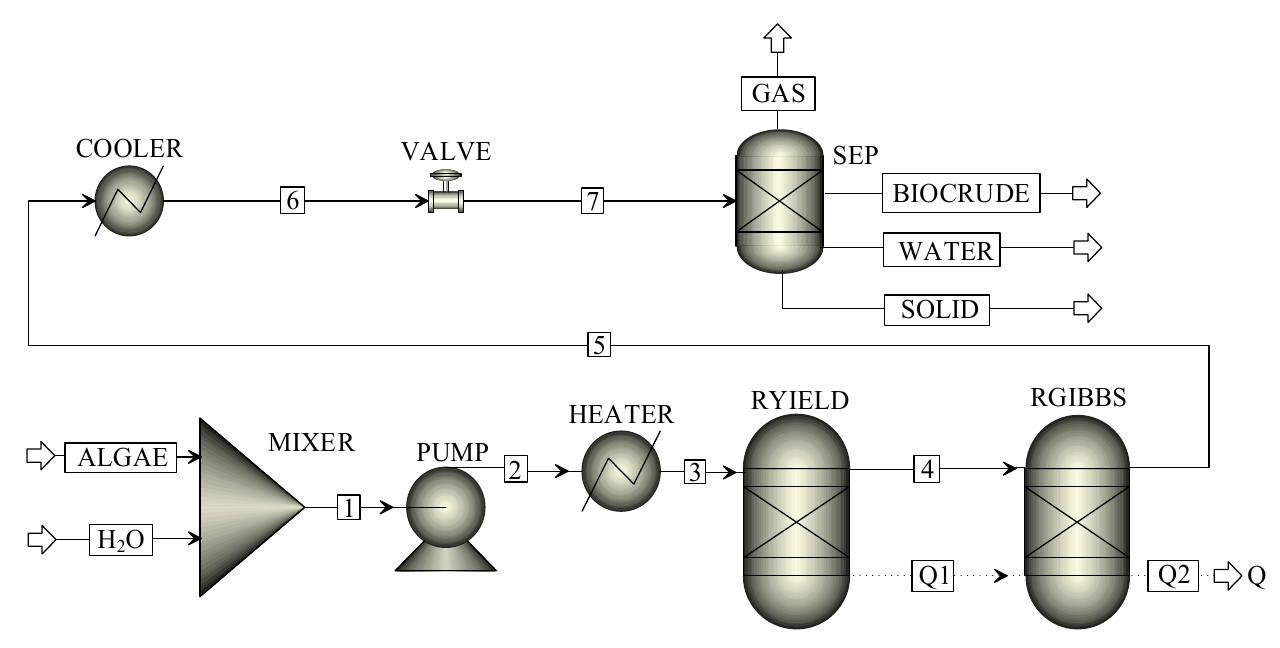
Figure 1. A continuous system for hydrothermal liquefaction of Chlorella .